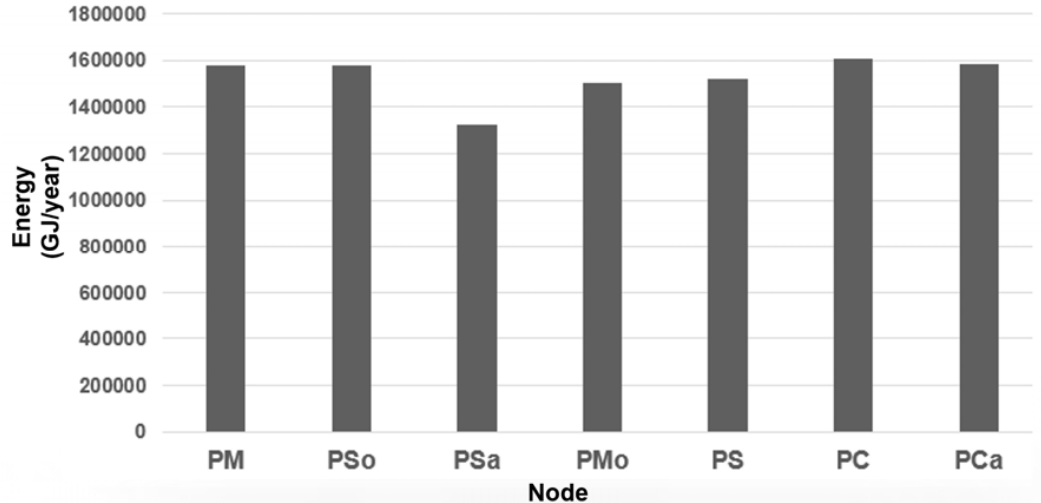
Figure 4. The energy (E) of the available biomass per candidate node as calculated by Equation (2).